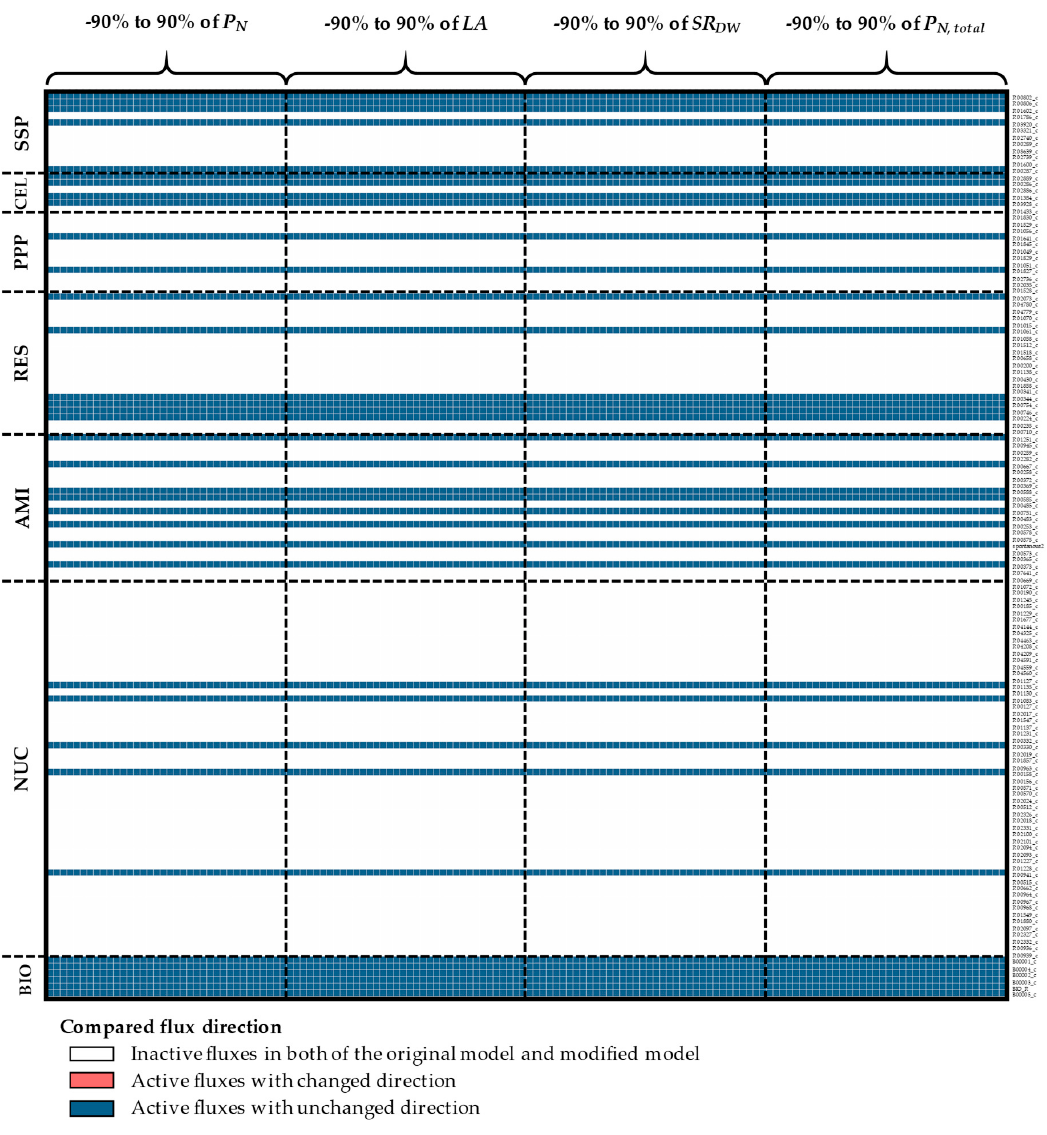
Figure A2. The sensitivity of the cytosolic reaction flux direction to variations in sucrose uptake rate-related data. Inactive reactions containing zero fluxes are denoted by white-colored grids. Active reactions, non-zero fluxes, with similar flux direction as the original model are denoted by blue grids; while those with dissimilar flux direction (breakpoint) are denoted by red grids. LA ; total leaf area per plant; P N , photosynthetic rate; P N, total , total photosynthetic rate per plant; SR DW , storage root dry weight per plant; AMI, amino acid biosynthesis pathway; BIO, biomass reactions; CEL, cell wall biosynthesis pathway; NUC, nucleotide biosynthesis pathway; PPP, pentose phosphate pathway; RES, respiration pathway; SSP, starch and sucrose biosynthesis pathway.